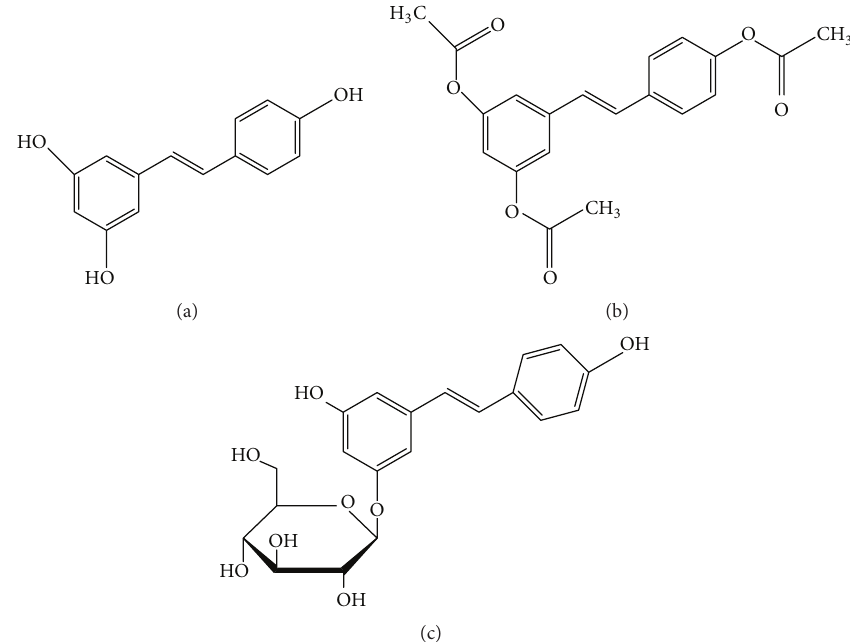
Figure 1: The chemical structures of resveratrol (a), acetyl-resveratrol (b), and polydatin